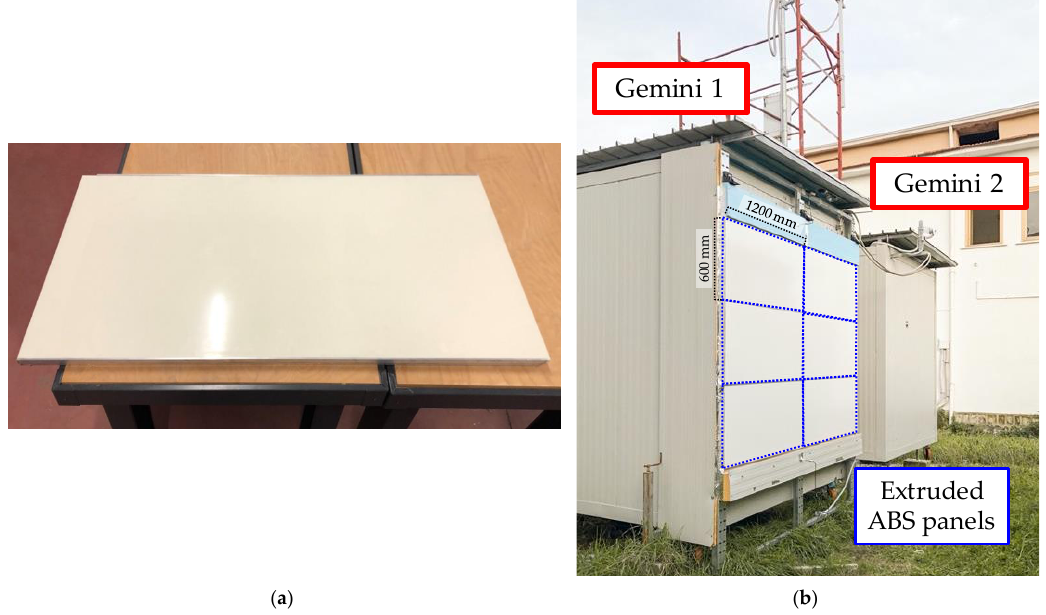
Figure 4. ( a ) Extruded ABS panels [54] detail view; ( b ) Gemini 1 equipped with the OVF system. The second-skin system equipped during the tests has been realized by mounting the six extruded ABS panels on a steel frame, then hanging the whole system to the brackets on the south facade of the test cell Gemini 1. Finally, the sides of the second-skin system were covered and sealed by means of panels, similar to those used for the test cells’ envelope, in order to allow only for a vertical airflow in the cavity (Figure 4b). In this configuration, the acquisition period lasted for almost a month, in the wintertime. During